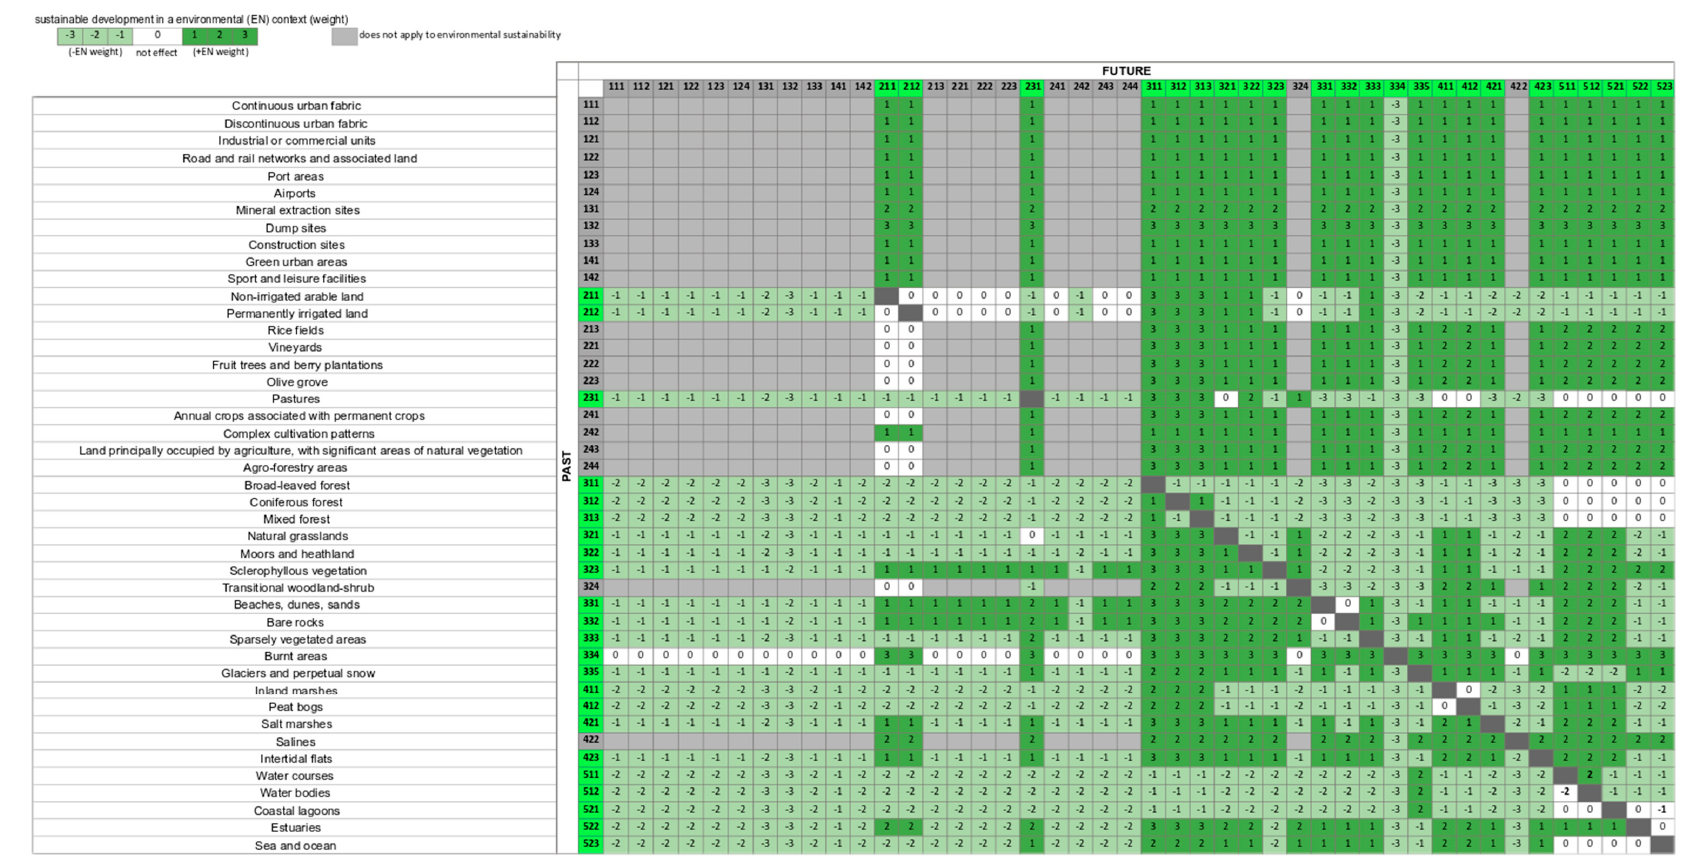
Figure A3. Land use change assessment matrix in the environmental aspect